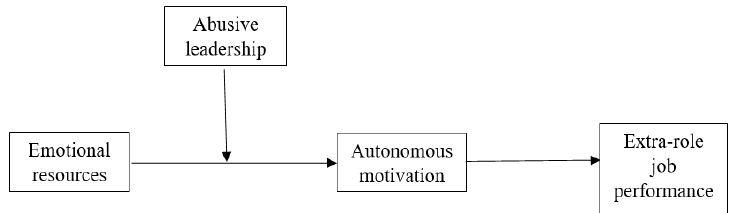
Figure 1. Hypothetical model. Note. See Table 3 for the indirect effects of emotional resources on extra-role job performance via autonomous motivation (Hypothesis 1). See Figure 2 and Table 3 for the moderated mediation effect of abusive leadership on the relationship between emotional resources and extra-role job performance.